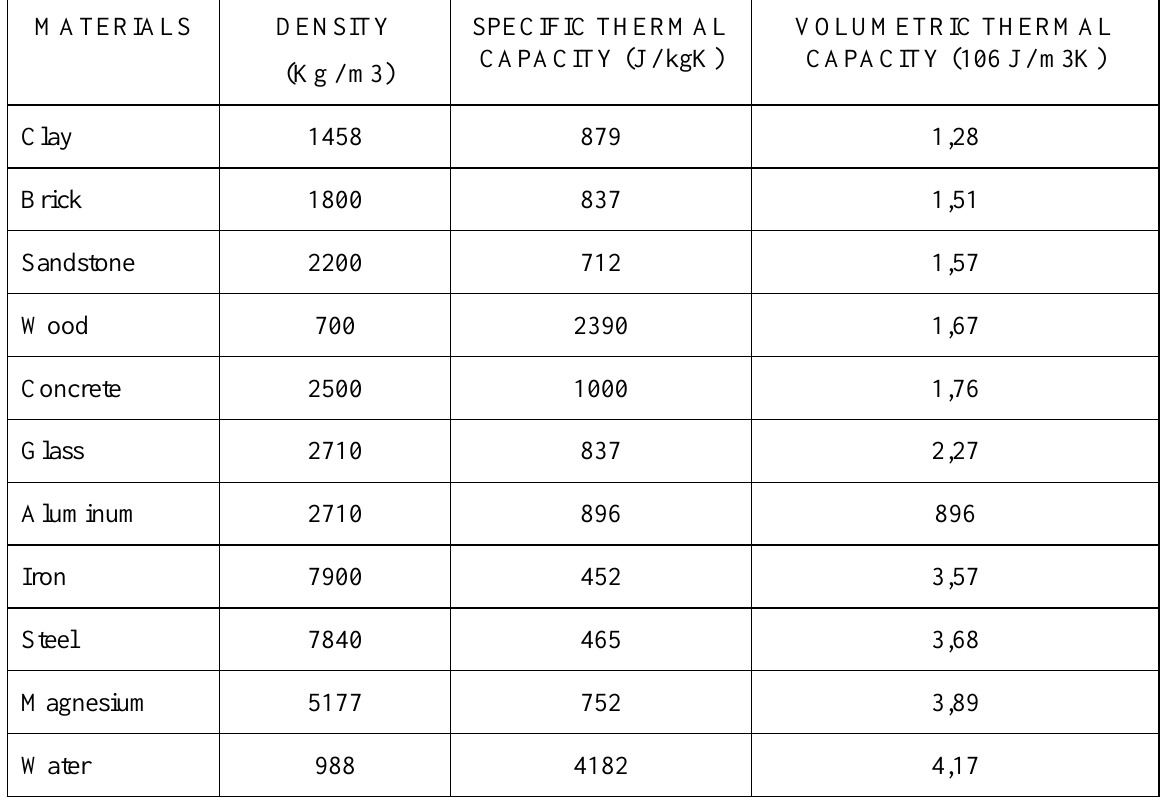
Table 1. Selected material